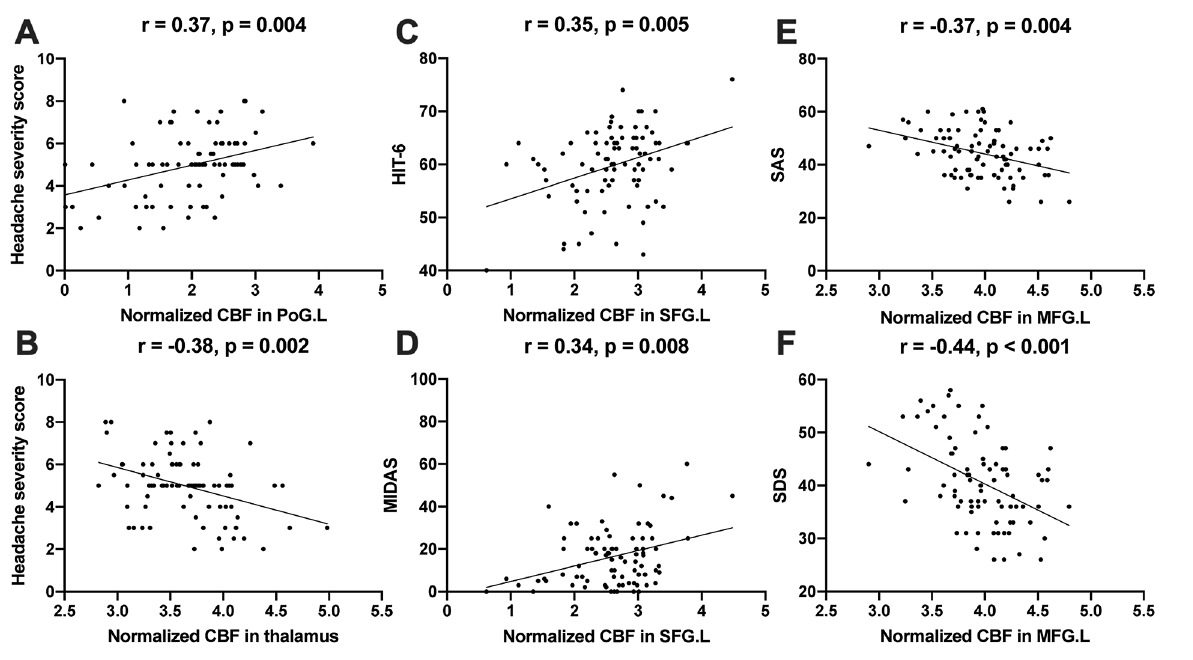
gyrus (PoG.L) and thalamus with headache severity score, normalized CBF in left superior frontal gyrus (SFG.L) with HIT and MIDAS, normalized CBF in left middle frontal gyrus (MFG.L) with SAS and SDS among all patients (A-F, all p values < 0.01, after FDR correction). CBF: cerebral blood flow, HIT-6: Headache Impact Test-6, MIDAS: Migraine Disability Assessment Score, SAS: Self-Rating Anxiety Scale, SDS: Self-Rating Depression Scale